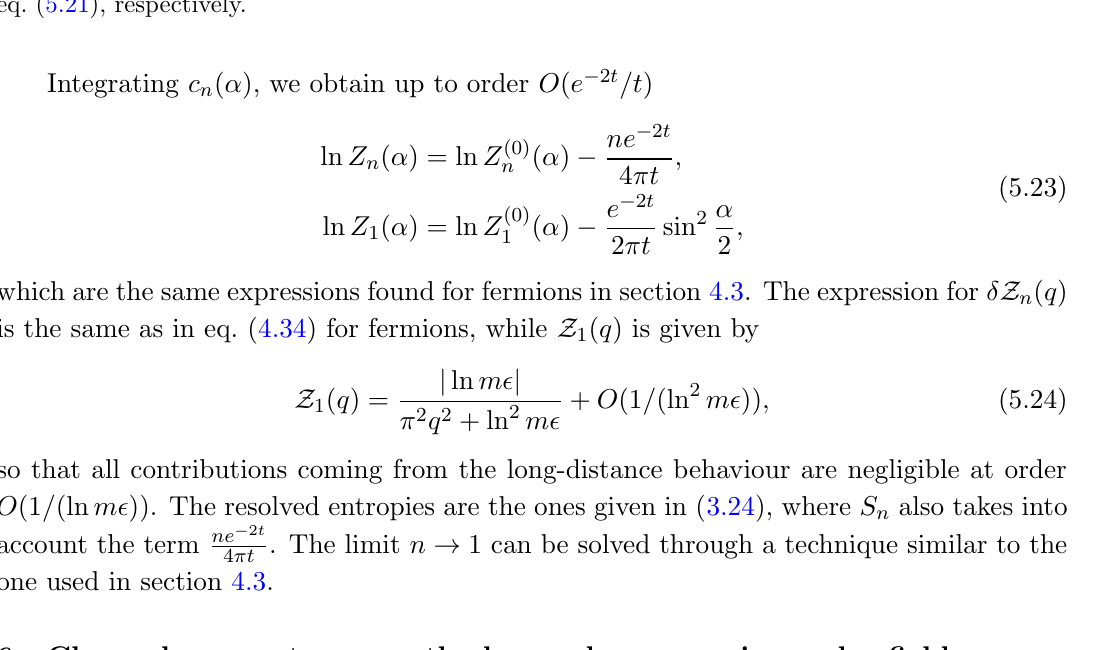
Figure 10 . The solid lines are the functions c n ( (cid:11) ) as solutions of eq. (5.6). The dashed lines are the short (red) and long (black) distance leading terms we evaluated analytically in eq. (5.10) and eq. (5.21),